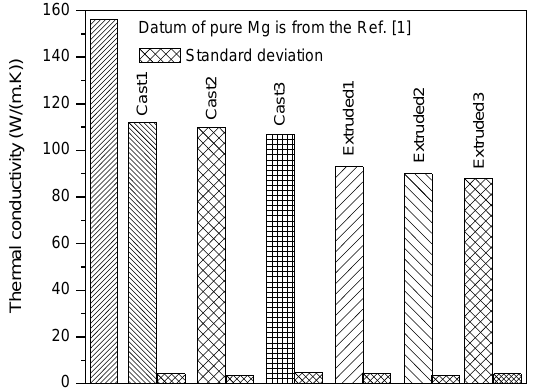
Figure 5. The thermal conductivity of the examined Mg alloys.